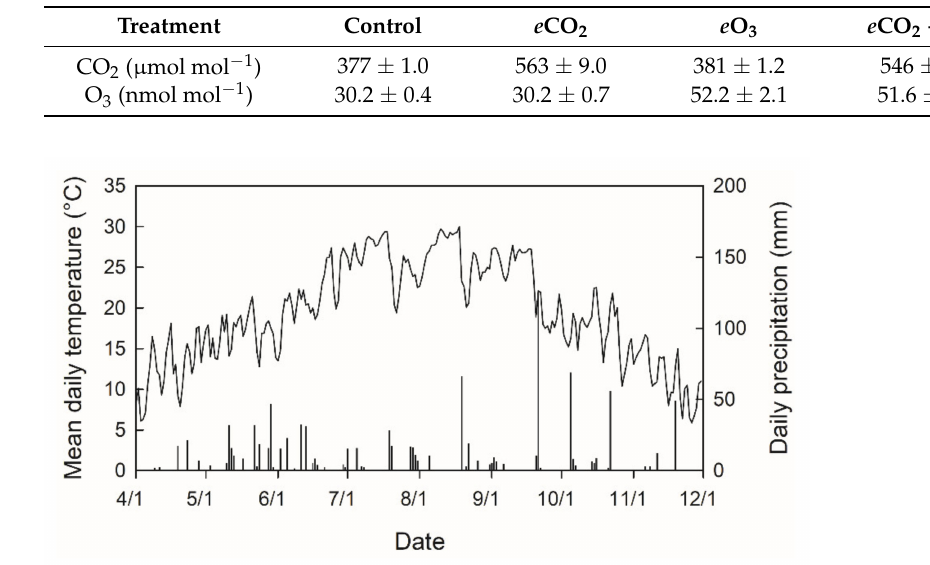
Figure 1. Mean daily temperature (solid line) and daily precipitation (solid bar) at the nursery of Forestry and Forest Products Research Institute in Tsukuba, Japan (36 ◦ 00 (cid:48) N, 140 ◦ 08 (cid:48) E, 20 m